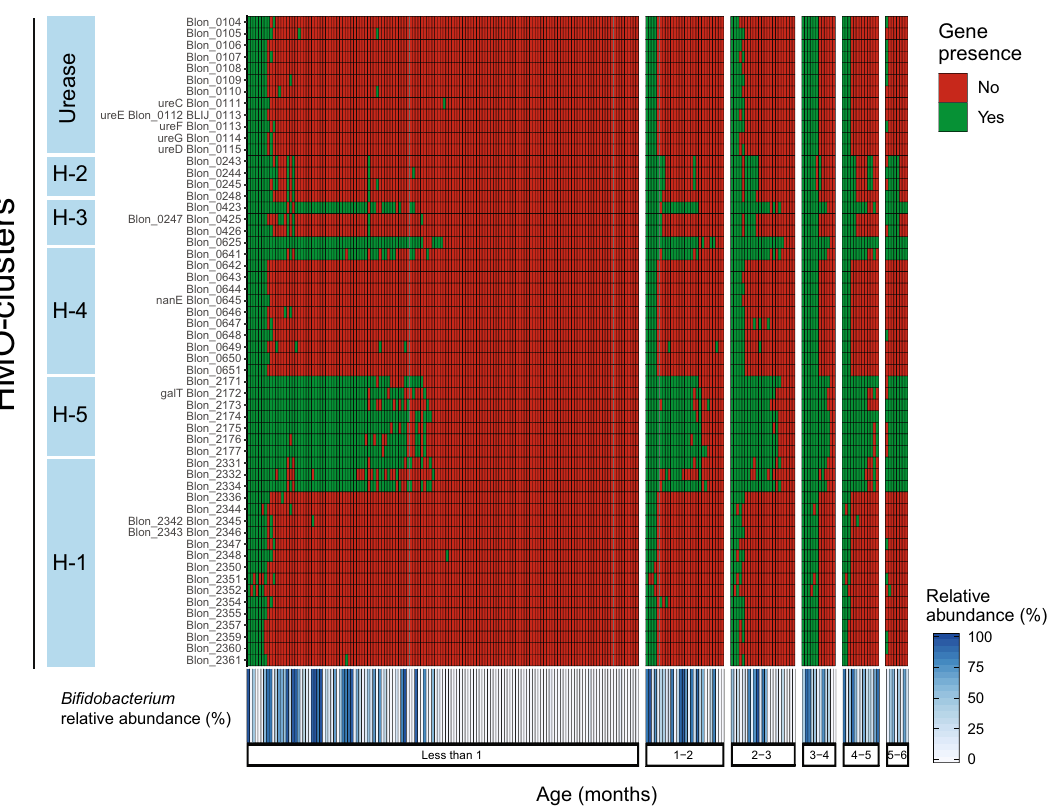
Figure 3. Functional HMO-cluster gene profiling by samples. ( A ) Heatmap showing presence/absence of the 56 HMO-cluster genes in all samples in the survey. Every column represents an individual sample and ordered by age block. Within a age block samples are ordered by decreasing presence of genes from left to right. Bottom of heatmap shows relative abundance (%) of Bifidobacterium by corresponding individual